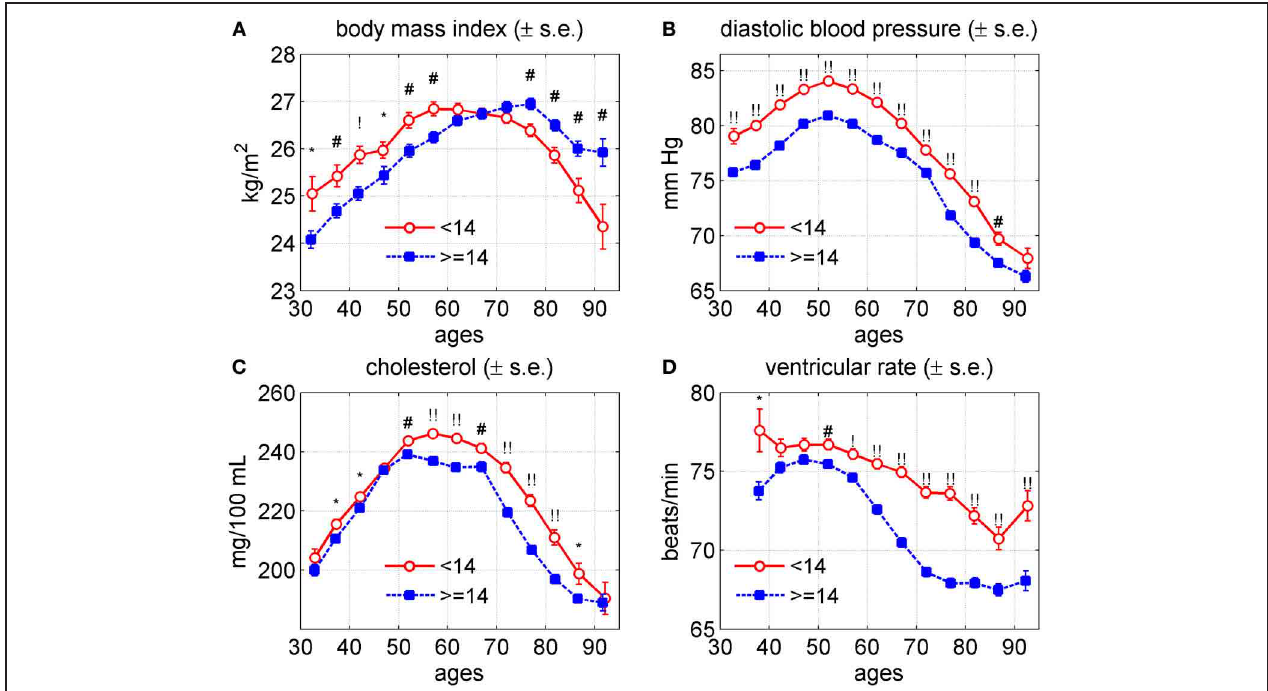
index; (B) diastolic blood pressure; (C) cholesterol; (D) ventricular rate. Symbols above the curves correspond to p -values for testing the